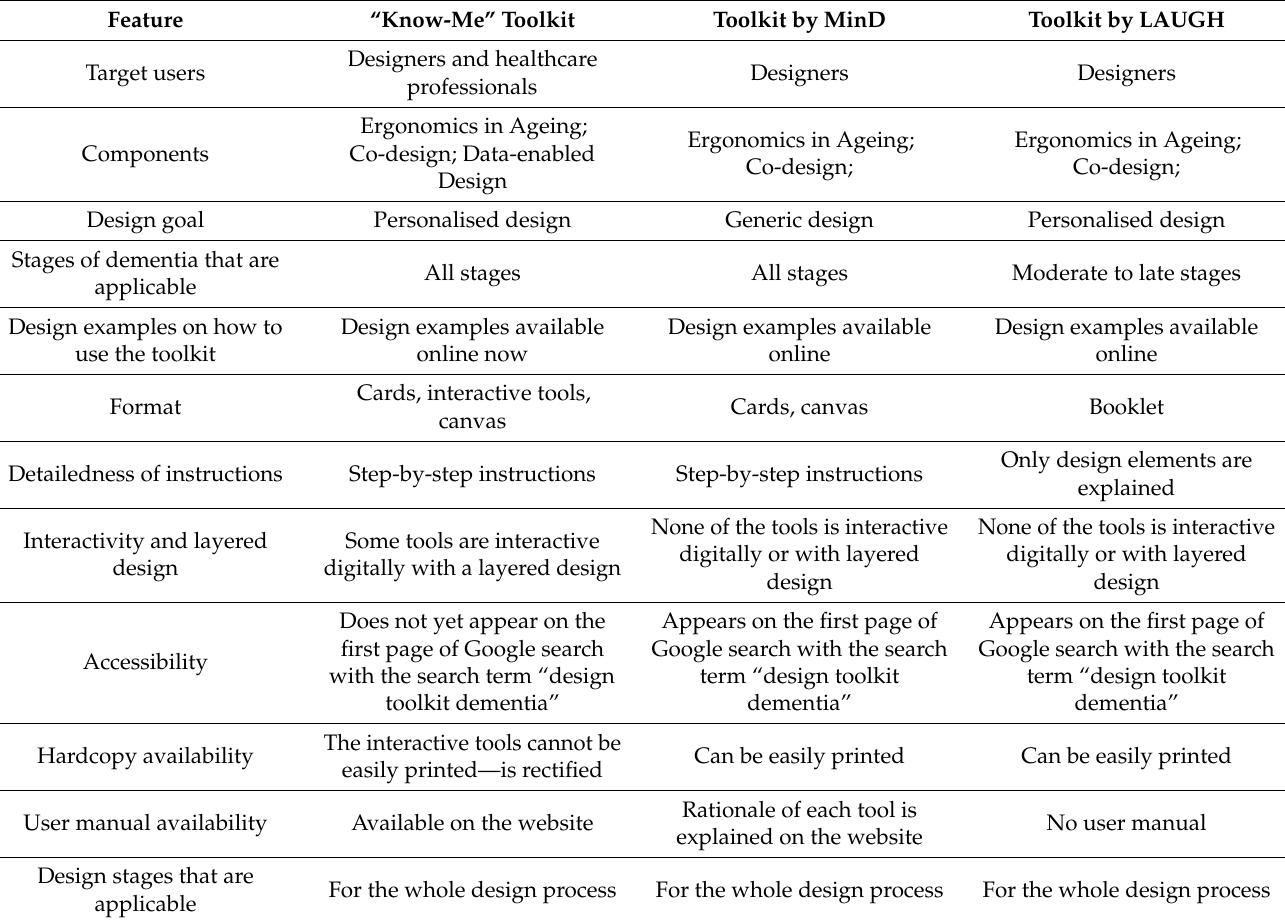
Table 3. Feature-by-feature comparison of the “Know-me” toolkit with similar state-of-the-art toolkits on design for dementia